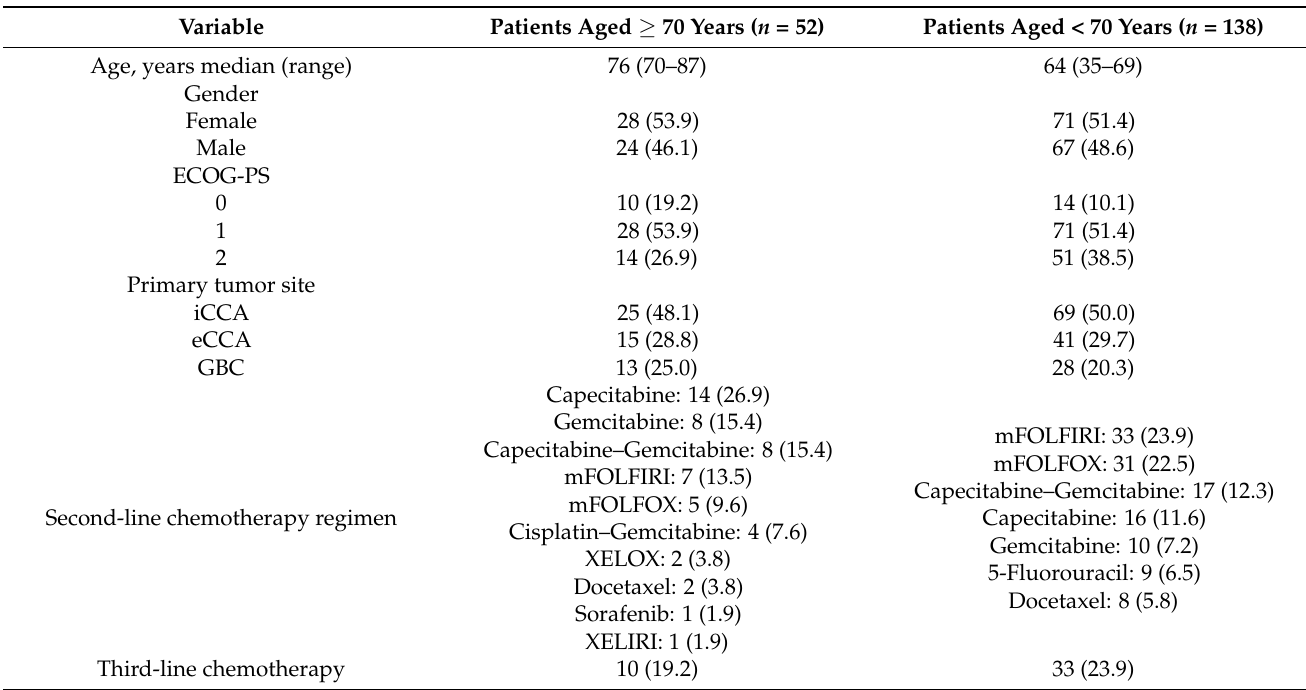
Table 1. Baseline patient characteristics ( n = 190). Abbreviations: eCCA—extrahepatic